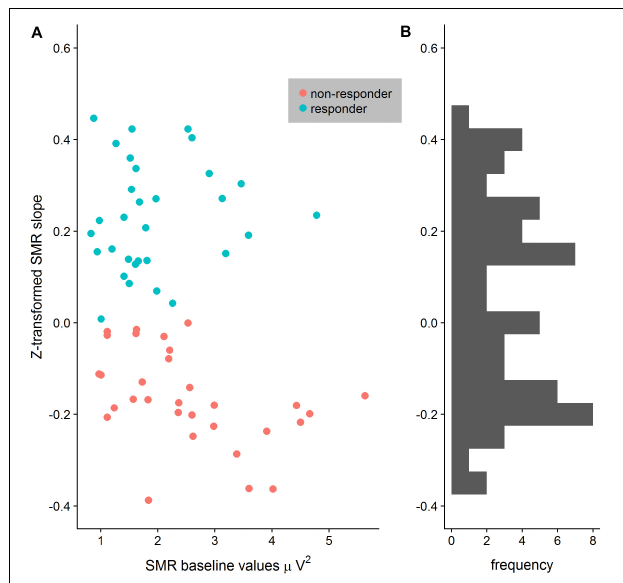
FIGURE 2 | (A) Distribution of z-transformed SMR slopes depicted in function of SMR baseline values separately for responders and non-responders. The separation between responders and non-responders is particular clear when SMR baseline values increase. (B) Histogram of the z-transformed SMR slopes reveals no central tendency but rather a bimodal